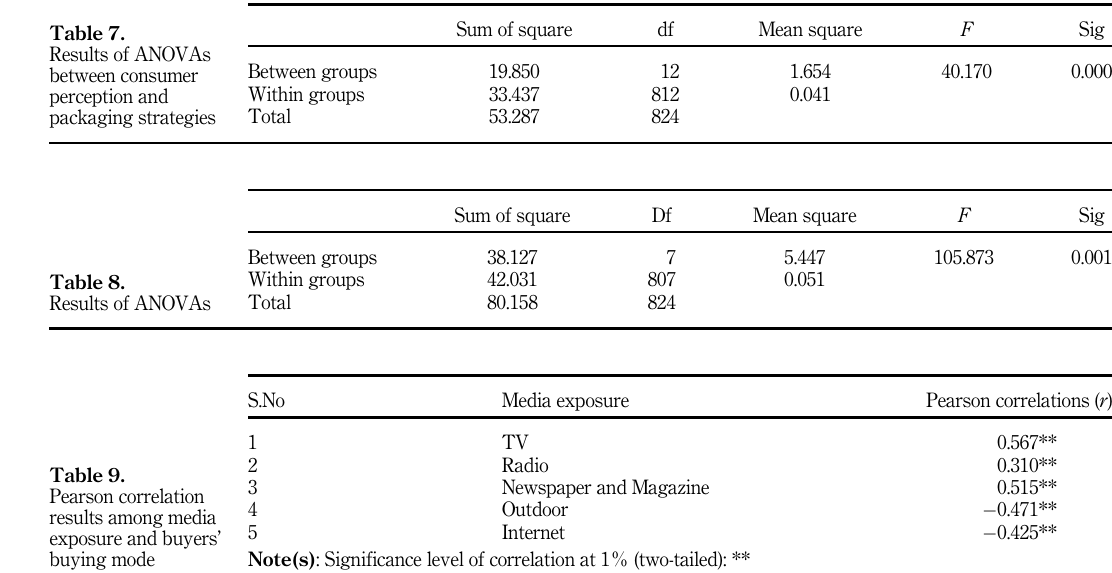
Table 9. Pearson correlation results among media exposure and buyers ’ buying